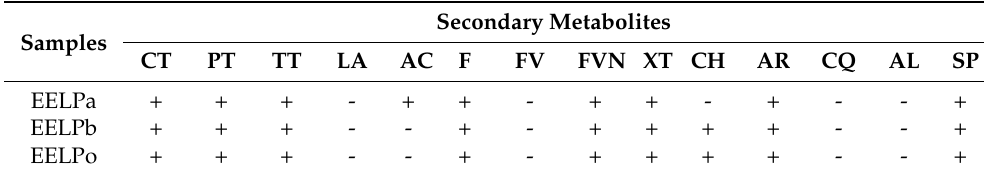
Table 1. Secondary metabolites classes identified in the ethanol extracts of fresh leaves of Plectranthus amboinicus , Plectranthus barbatus , and Plectranthus ornatus